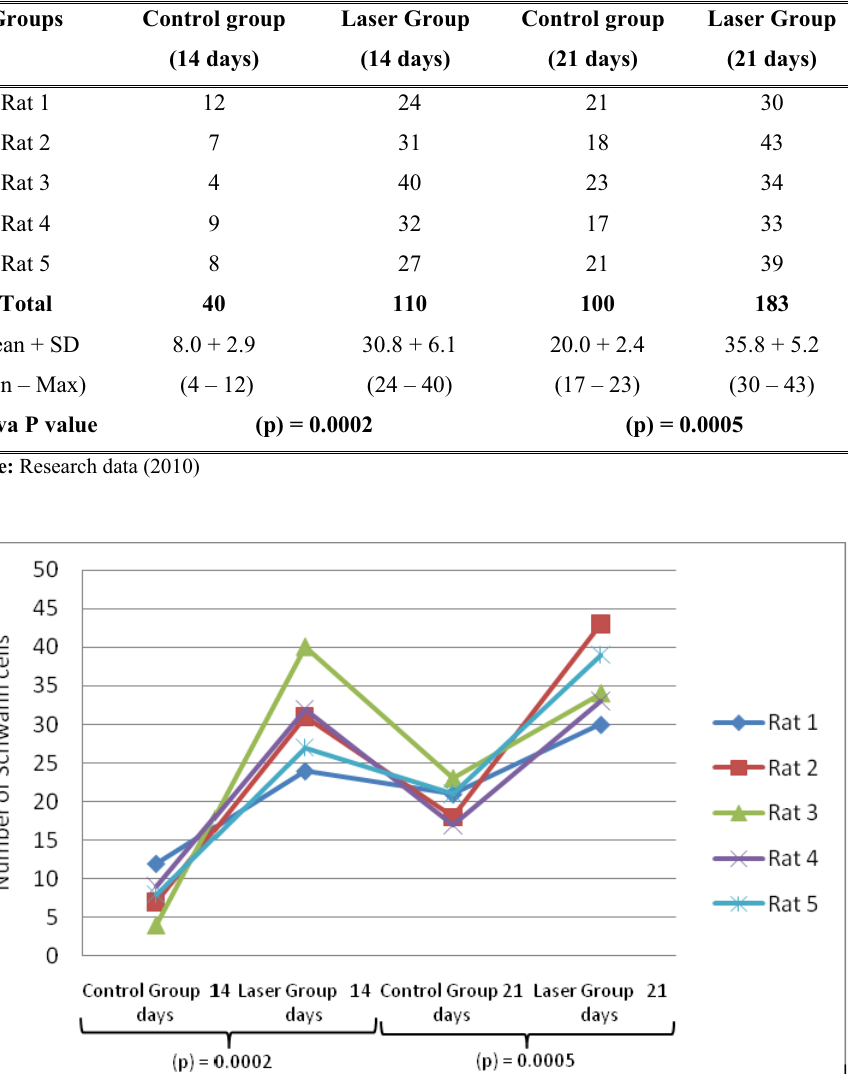
FIGURE 5 – Presence of Schwann cells in the histological findings at groups in 14 and 21 days. Source: Fieldwork archive, 2010.